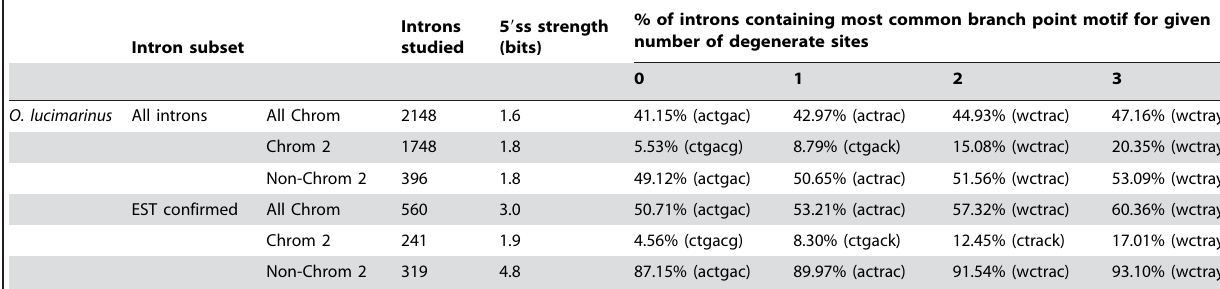
Table 3. Intron signal features for different intron subsets of O. lucimarinus.